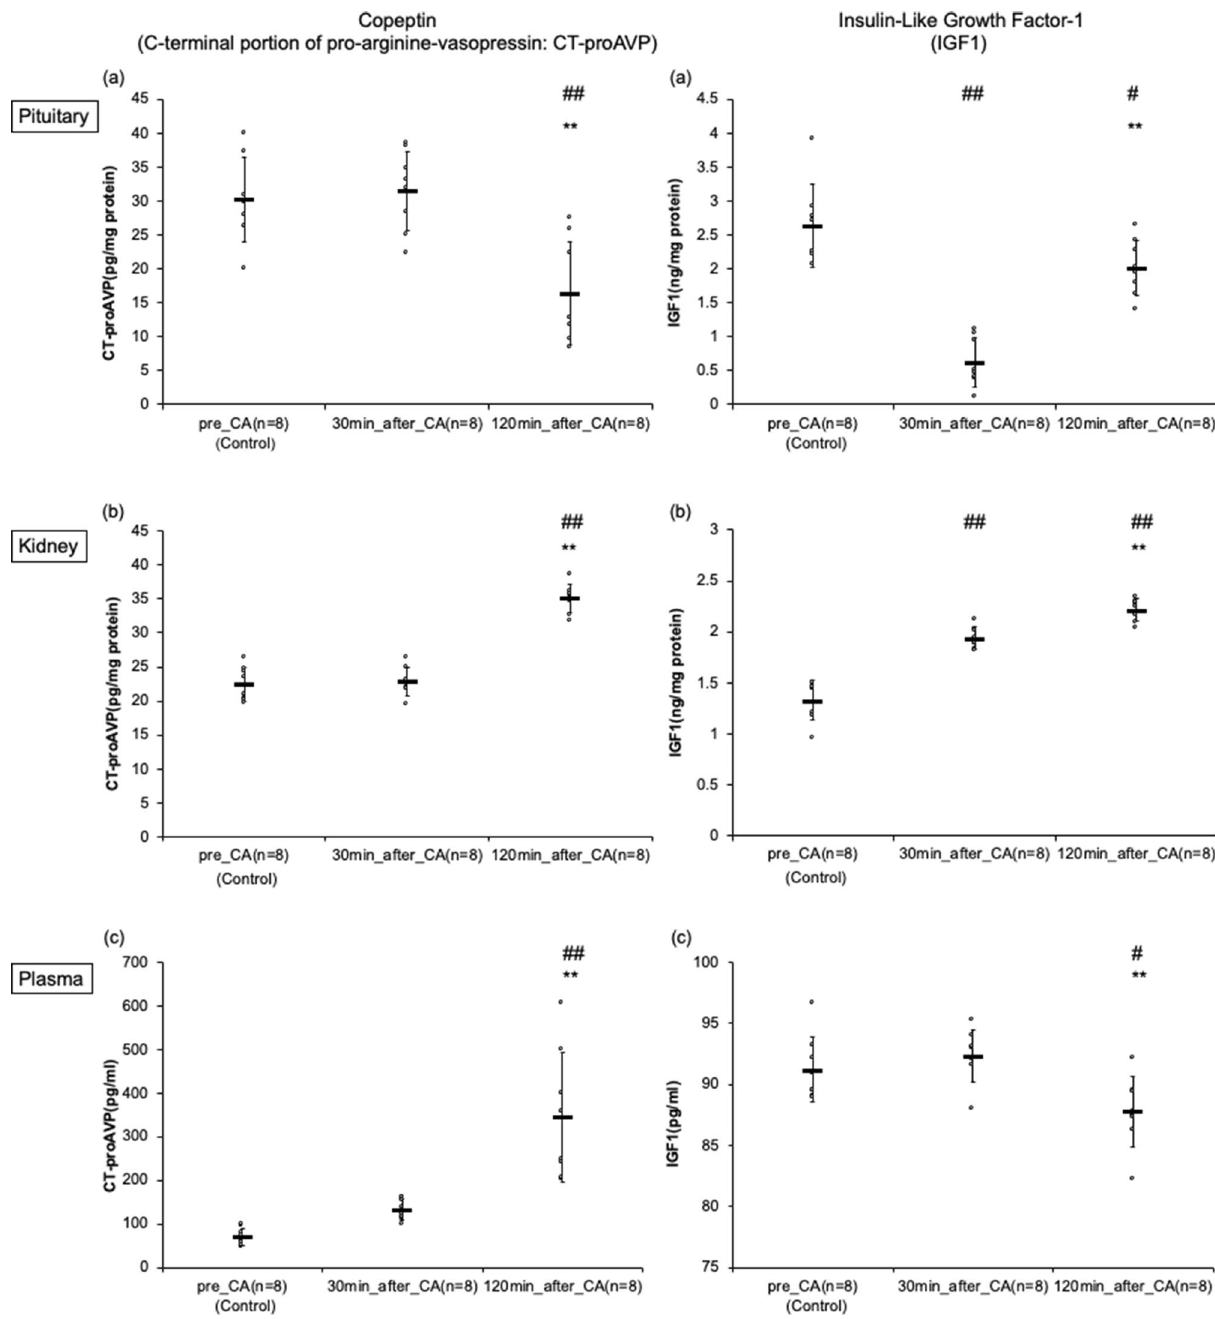
Figure 4. Dynamic quantitative measures of copeptin (C-terminal portion of pro-arginine-vasopressin: CT-proAVP) of the pituitary, kidney, and plasma, insulin-like growth factor-1 (IGF1) of the pituitary, kidney, and plasma by enzyme-linked immunosorbent assay in asphyxial cardiac arrest (CA) rats. ( a ) This indicates the results of the pituitary. ## p < 0.01 compared with the pre-CA group. ** p < 0.01 compared with 30 min post-CA group. ( b ) This shows the results of kidney. ## p < 0.01 compared with the pre-CA group. ** p < 0.01 compared with 30 min post-CA group. ( c ) This shows the results of the plasma. ## p < 0.01 compared with the pre-CA group. ** p < 0.01 compared with 30 min post-CA group. Numbers are expressed as mean ±